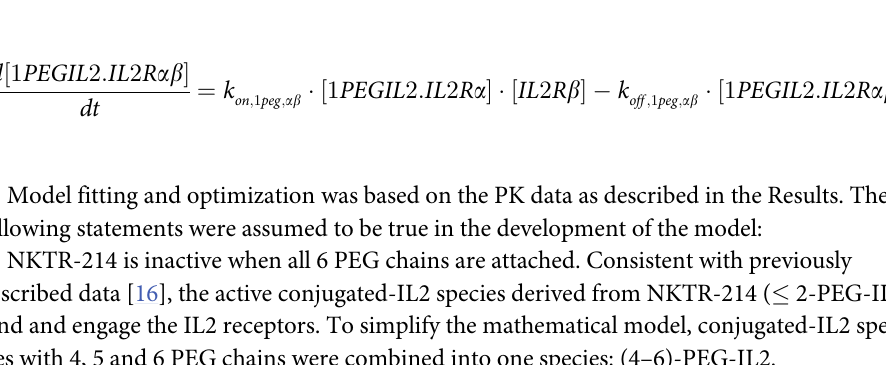
PLOS ONE | https://doi.org/10.1371/journal.pone.0179431 July 5,